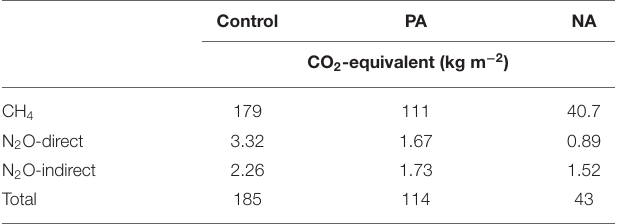
TABLE 4 | Total greenhouse gas emissions presented on a CO 2 -equivalent basis (kg m − 2 ) for methane (CH 4 ), nitrous oxide (N 2 O), and indirect N 2 O from ammonia (NH 3 ) over the entire 145-d monitoring period from the control, previously acidified (PA) inoculum, and newly acidified (NA) inoculum treatments.